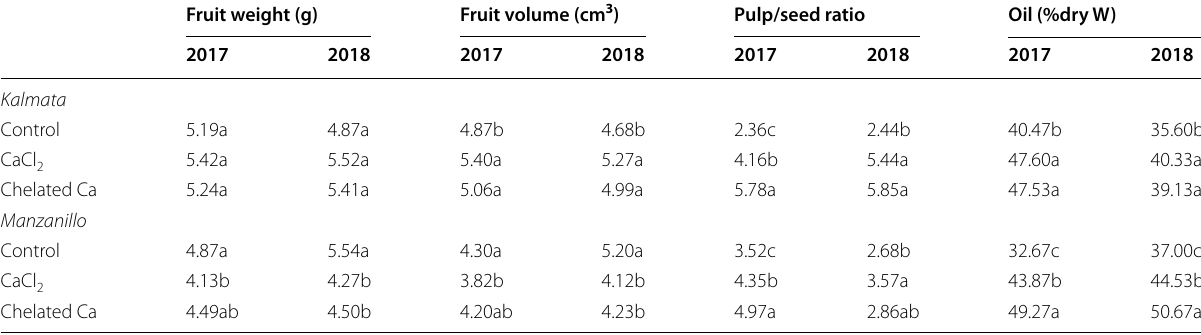
Table 3 Effect of foliar spray with some calcium sources on fruit quality and oil percentage of olive Kalmata and Manzanillo